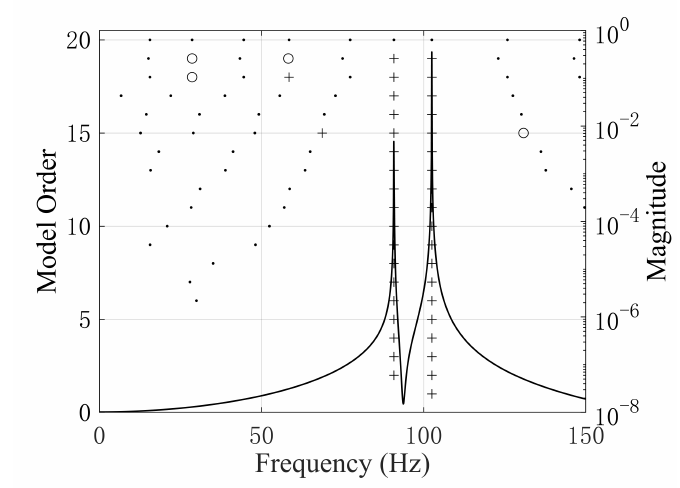
Figure 11. Stabilization diagram of OLS of central freeplay computed by TNSI method using the estimated FRF ( H 22 ). (Dot: Not stable in frequency; Circle: Stable in frequency; Cross: Stable in frequency and damping.).